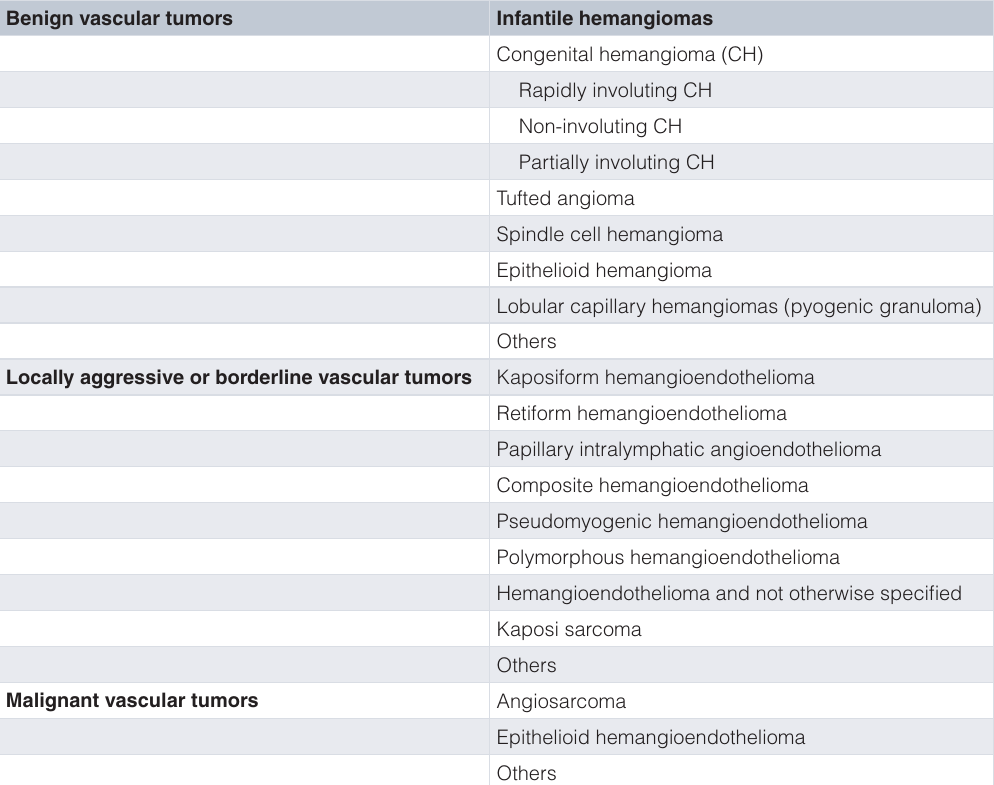
Table 1. International Society for the Study of Vascular Anomalies (ISSVA) classification of vascular tumors 23 . Benign vascular